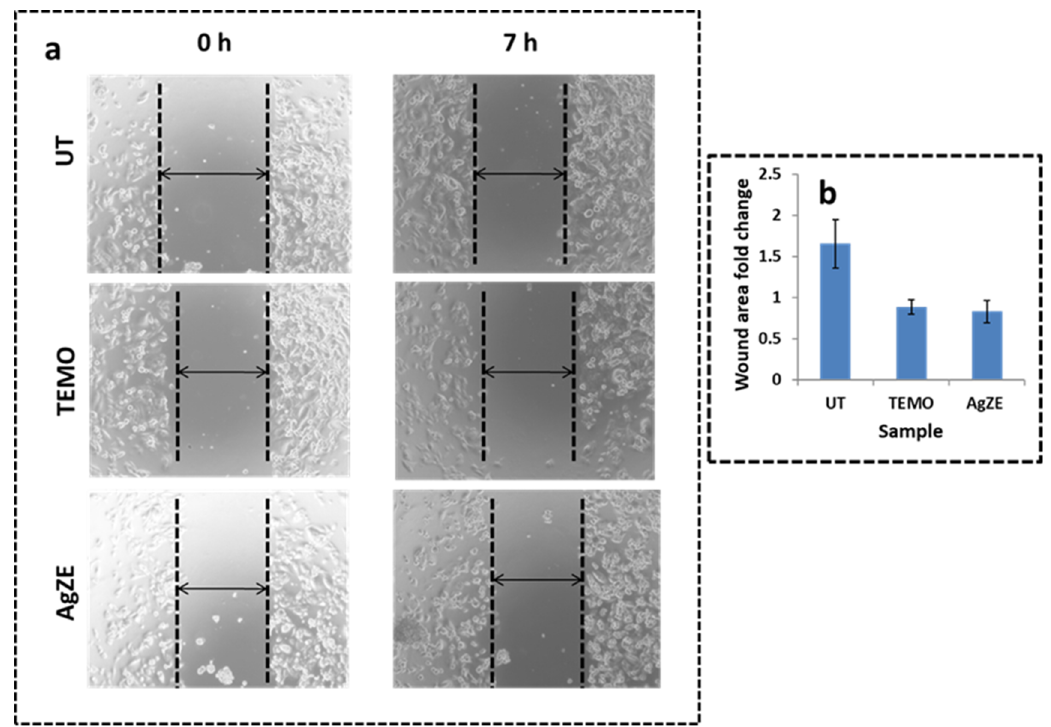
Figure 3. ( a ) Determination of wound healing of U-87 cell lines for untreated (first row). The AgZE inhibits the migration of cells (IC50: 4.1 µL = 0.94 µg/mL) compared to untreated cells. ( b ) Histogram representation of healing of wound area is calculated using Image J software which indicates less change in AgZE treated wound area as compared to the untreated sample. These experiments are performed thrice and represented as the mean ± SD.